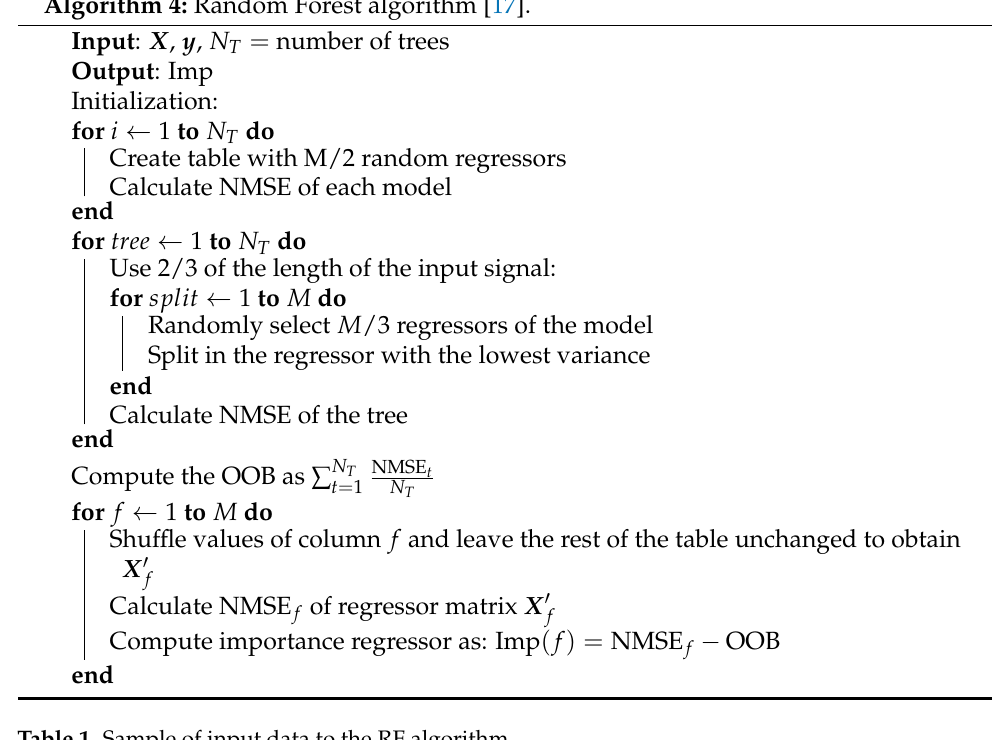
Table 1. Sample of input data to the RF